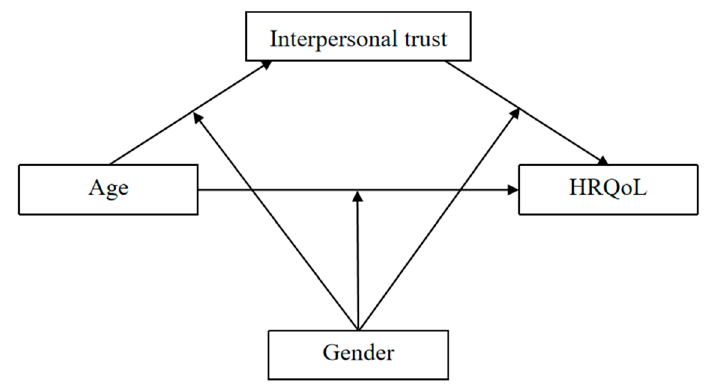
Figure 1. Hypothesized model.